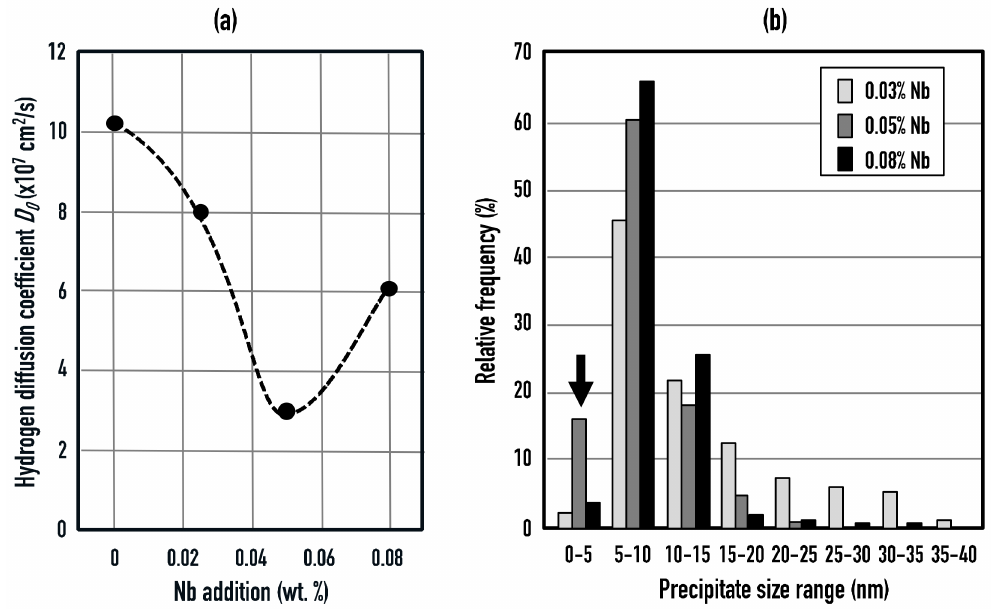
Figure 17. ( a ) Effect of niobium alloying on the hydrogen diffusion coefficient measured by hydrogen permeation tests; ( b ) size distribution of NbC precipitates measured by transmission elcectron microscopy